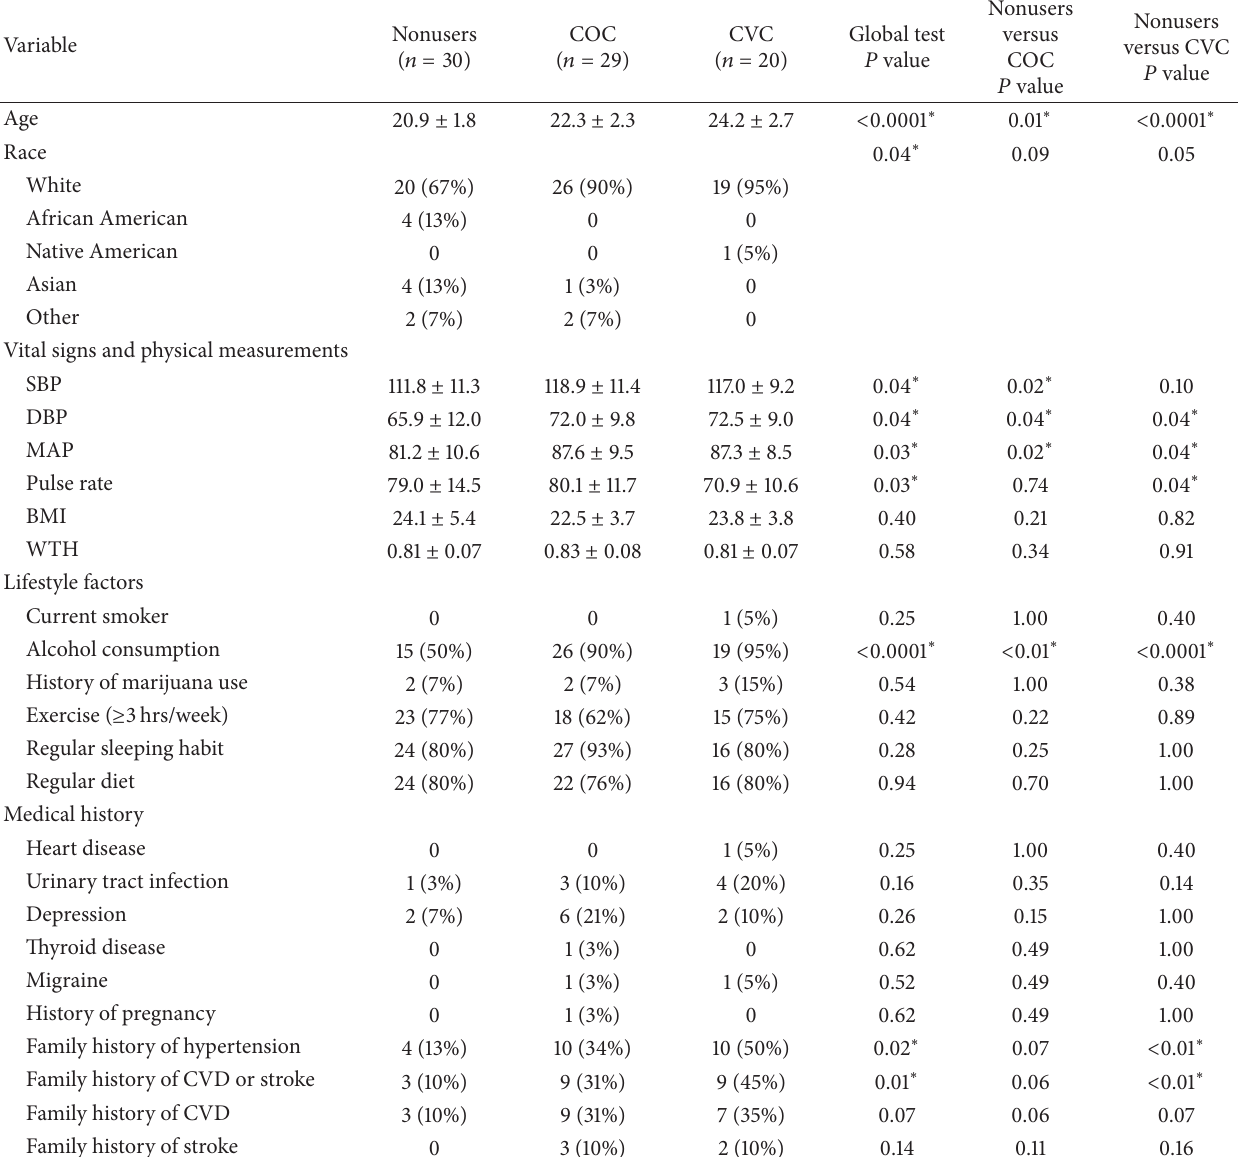
Table 1: Demographics, vital signs and physical measurements, lifestyle, and medical history of the selected recruited